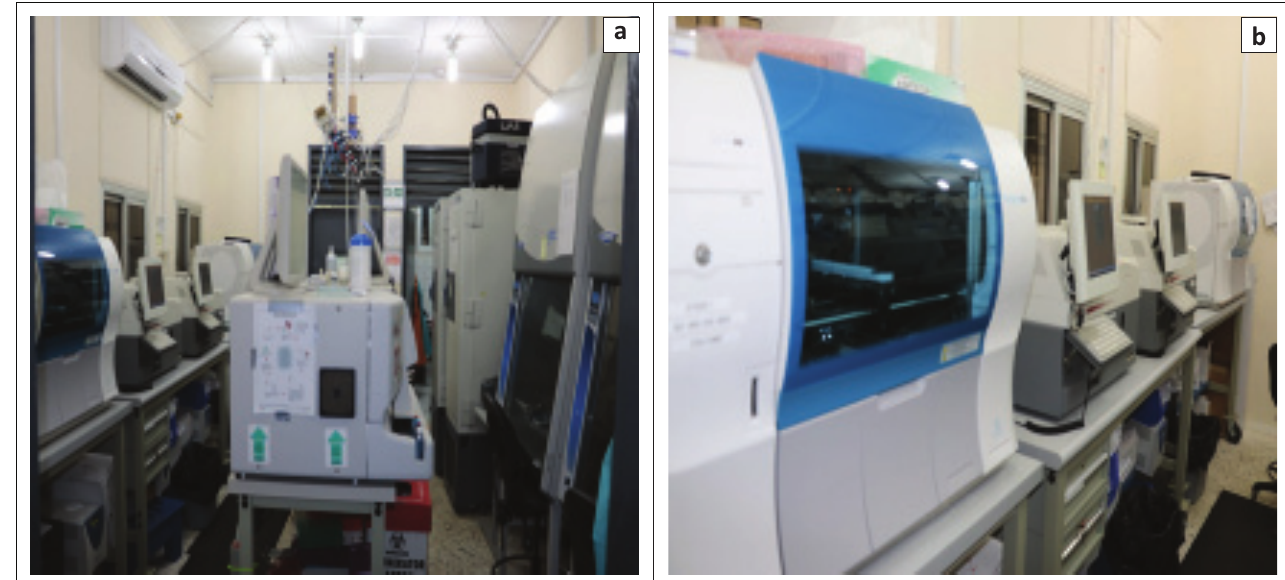
FIGURE 3: Post-Ebola virus disease technology enhancement at Redemption